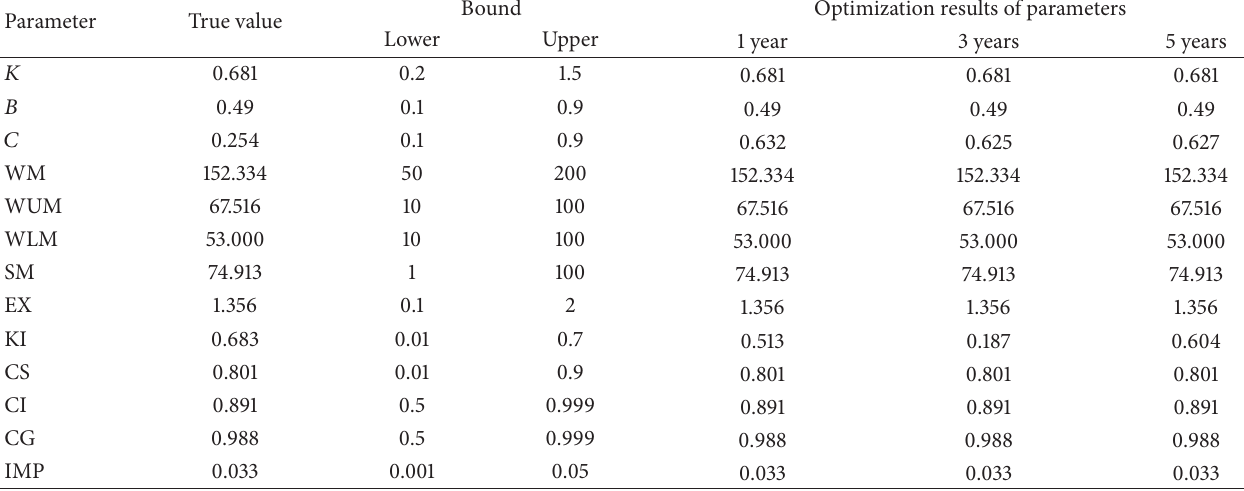
Table 7: Parameter optimization